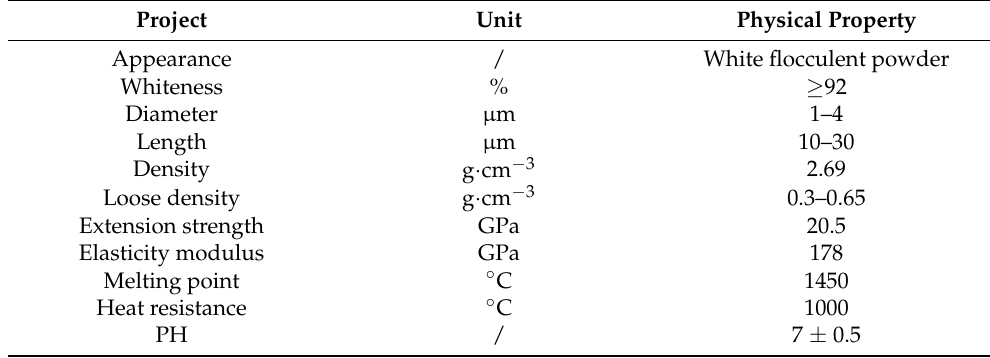
Table 2. Physical properties of ACSW.